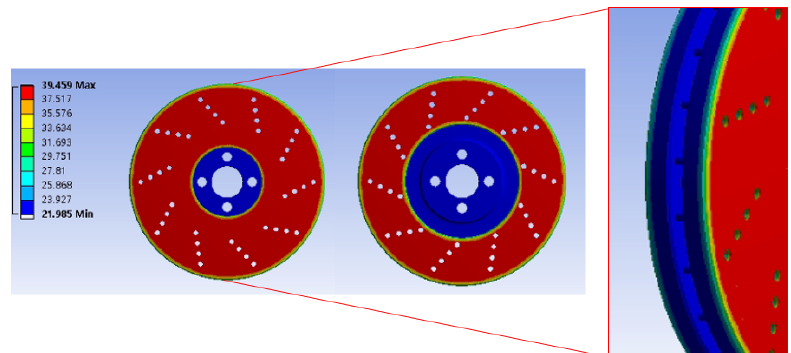
Figure 8. Temperature distribution of disc.